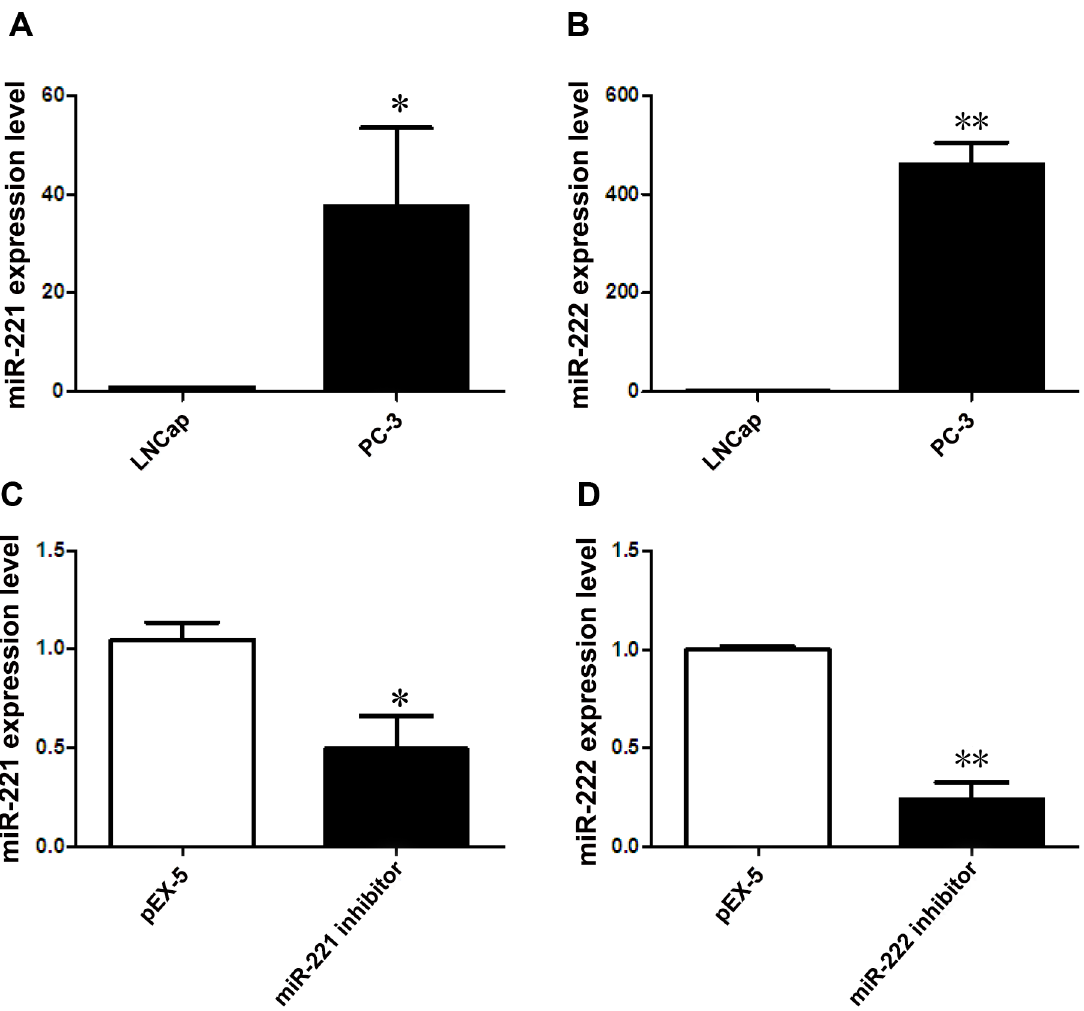
Figure 1. miR-221 and miR-222 expression in PCa cells. ( A ) miR-221 levels in PC-3 and LNCap cells. ( B ) miR-222 levels in PC-3 and LNCap cells. ( C ) miR-221 levels in PC-3 cells after transfection with pEX-5 (empty vector plasmid) or miR-221 inhibitor. ( D ) miR-222 levels in PC-3 cells after transfection with pEX-5 or miR-222 inhibitor. Data represent the mean value 6 SEM from three separate experiments. * P , 0.05, ** P , 0.01